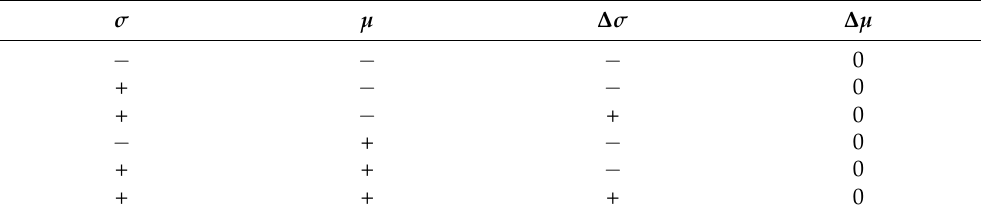
Table 1. Configurations of standard deviation, bias, and variation standard deviation to test and evaluate the reliability of